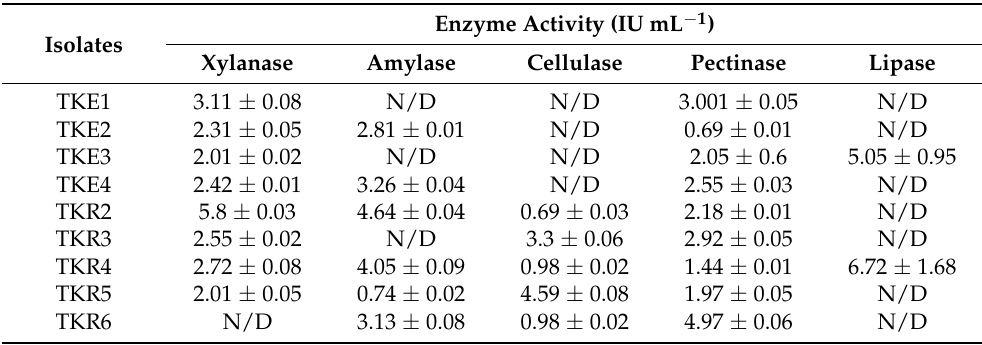
Table 5. Amounts of enzymes produced by each of the isolates using natural substrate shown in international units of enzyme (IU mL − 1